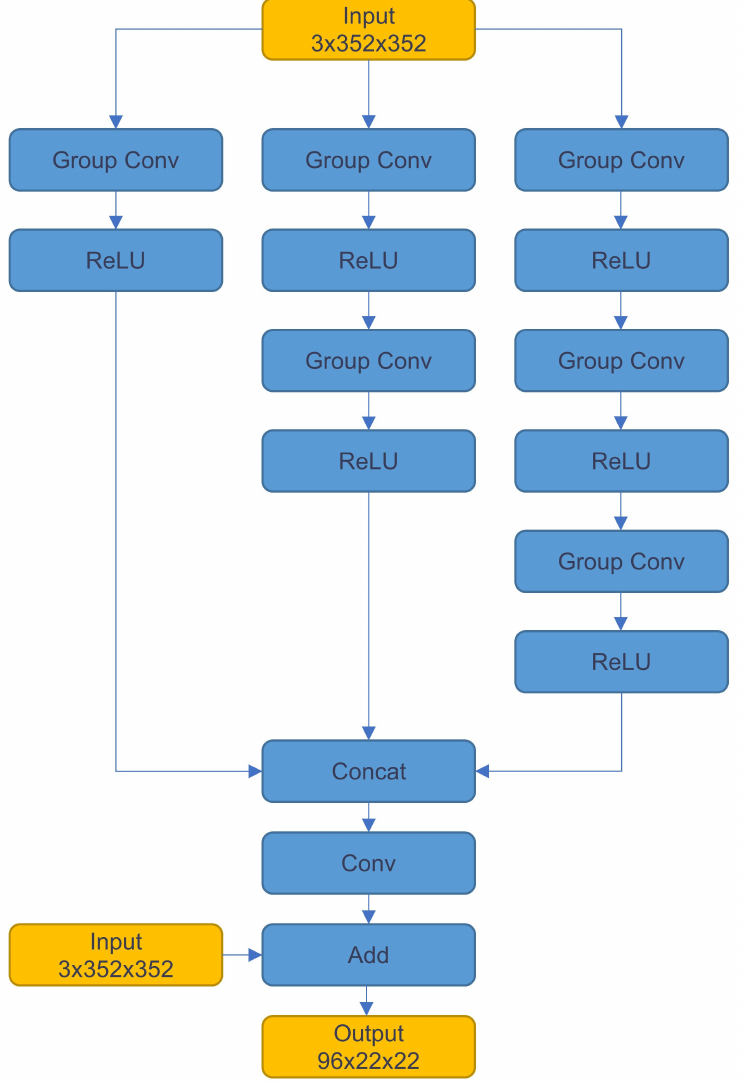
Figure 5. Detection head multi-channel fusion